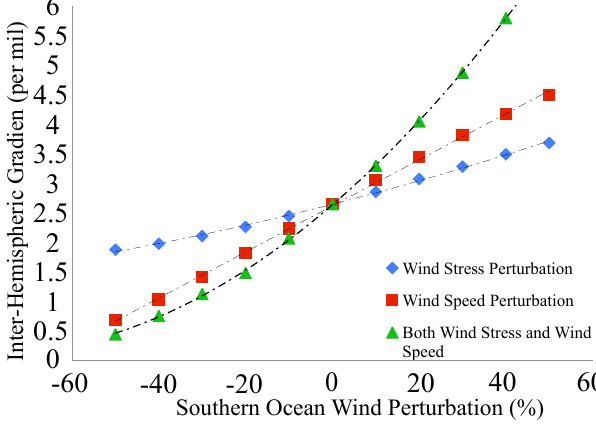
Fig. 6. Scatterplot of response of the interhemispheric gradient of atmospheric 1 14 C to surface windspeed perturbations after 20yr.